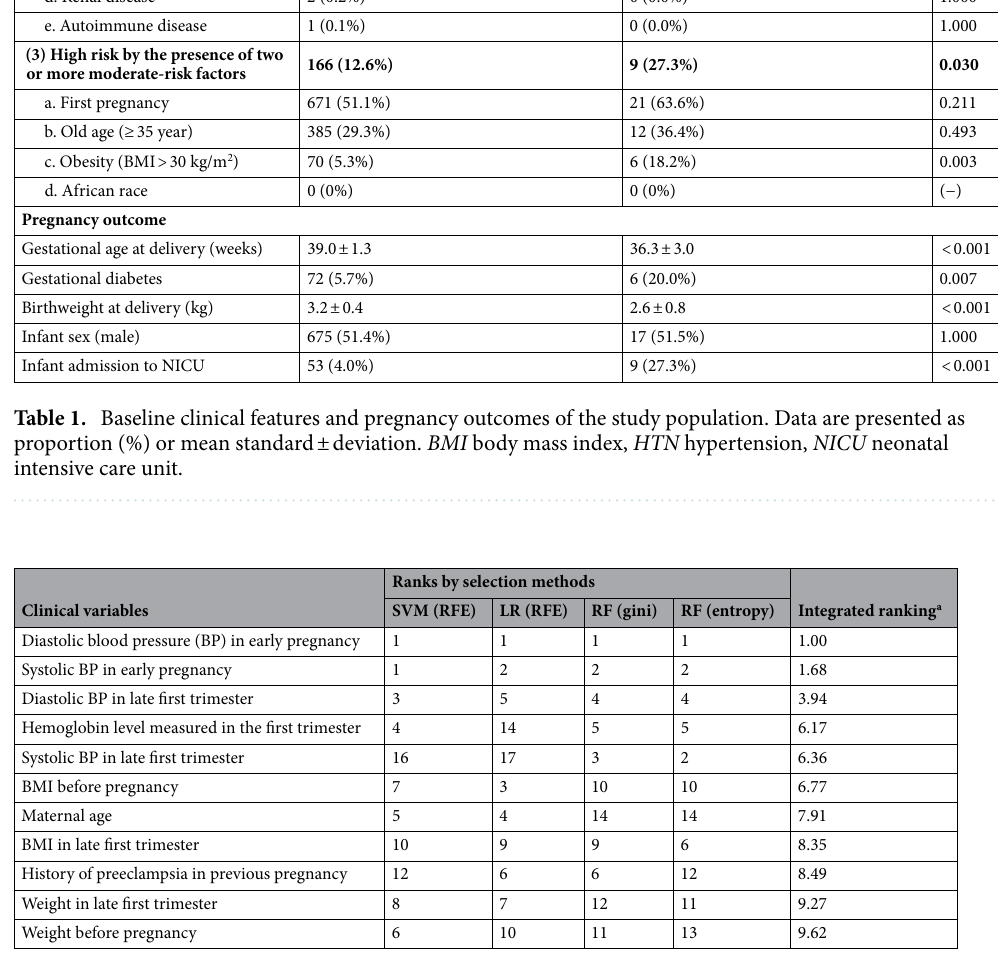
1 n r i (cid:29) n n √ r 1 r 2 . . . r n where r i is the variable ranks in i th selection 1 i = −